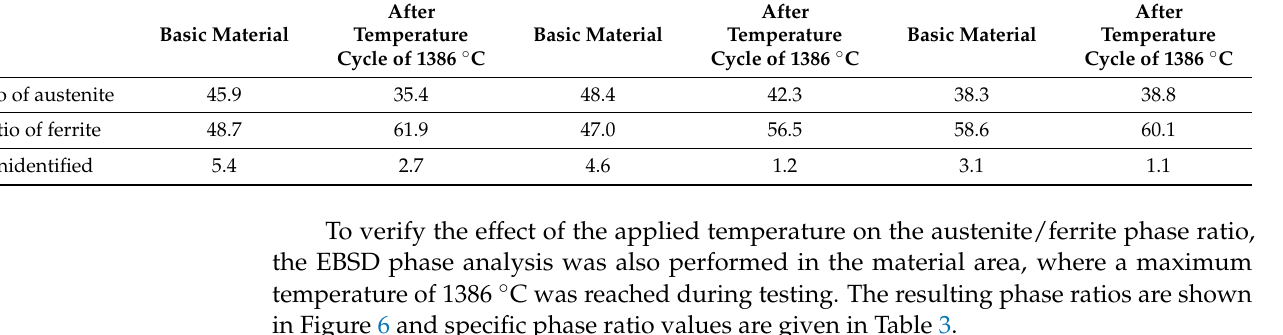
Figure 5. Distribution of ferrite (green) and austenite (red) in the basic material along with the following directions: ( a ) x -axis (direction perpendicular to the rolling direction), ( b ) y -axis (rolling direction), and ( c ) z -axis (material thickness direction). Table 3. Percentage ratios of the individual phases along with the given directions: X, Y, and z -axis. x -axis